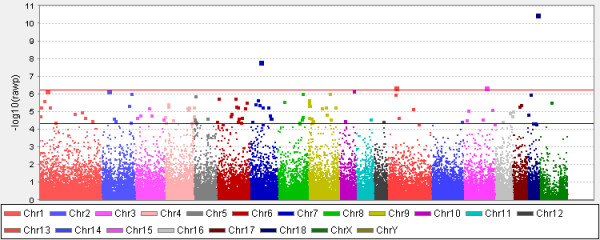
Manhattan plot of genome wide association results for backfat thickness in Italian Large White pigs. Red line: significance threshold (P=5.0E-07). Blue line (P=5.0E-05): threshold for suggestively significant results (5.0E-07<P<5.0E-05).